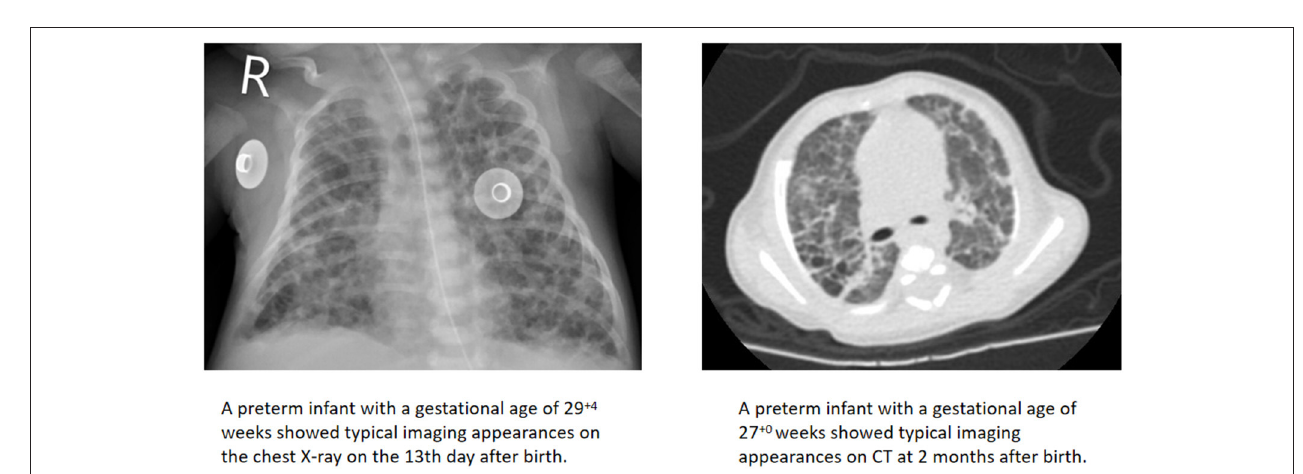
FIGURE 2 | Representative of typical imaging